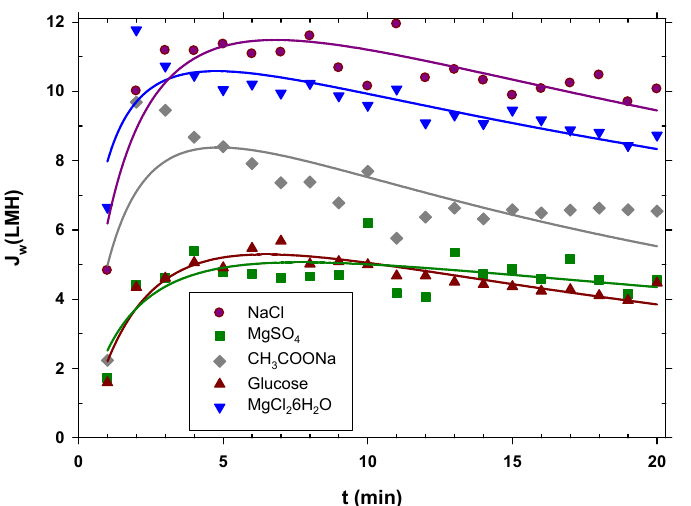
Figure 4. Water flux for the different types of draw solutions used over time. The curve is just a visual guide.